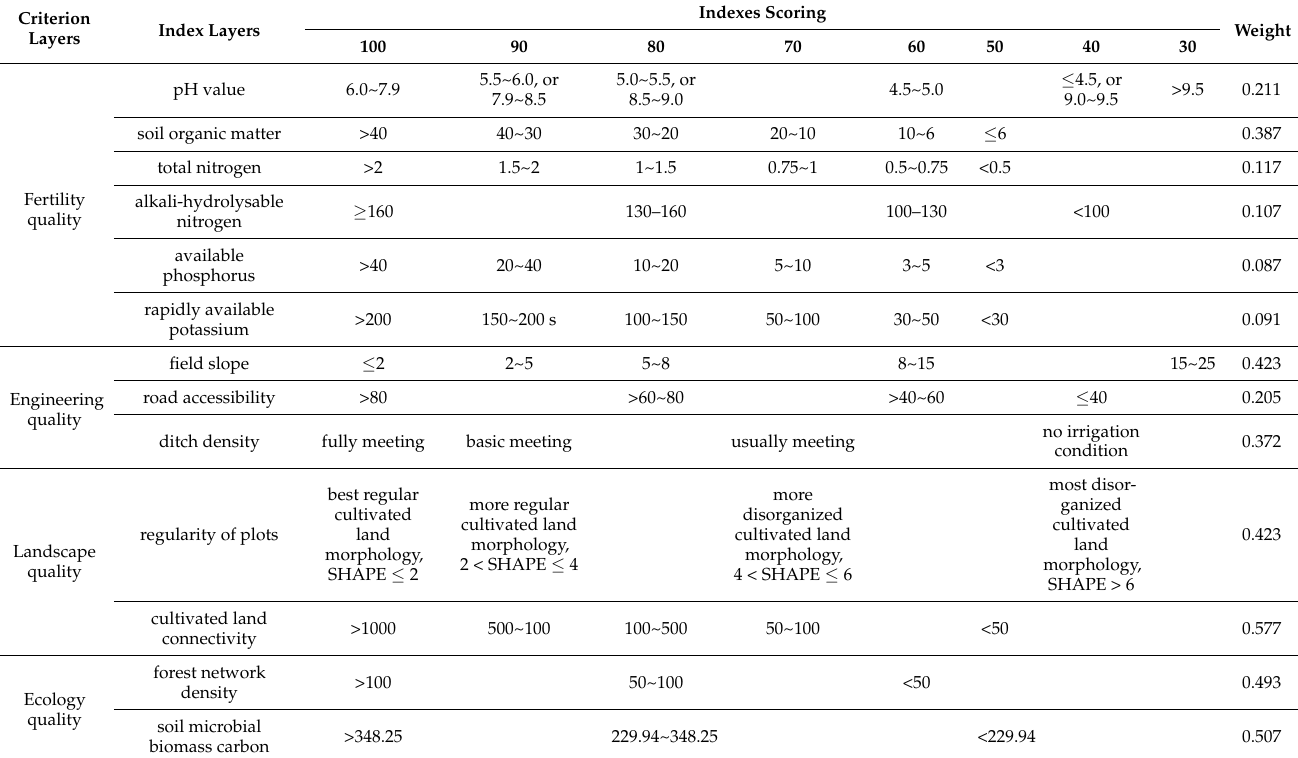
Table 3. Classification and weights of cultivated land quality evaluation